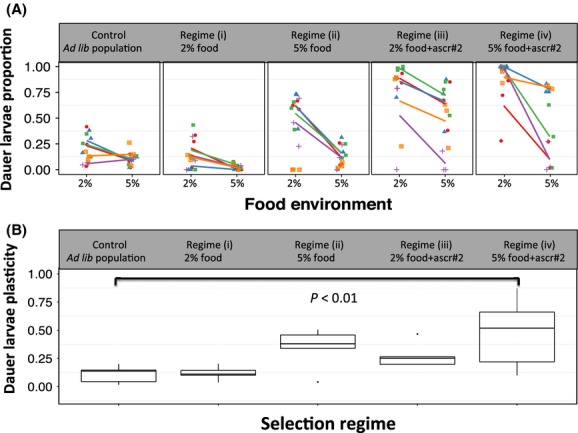
(A) The proportion of dauer larvae formed by lines selected in regimes (i)–(iv), and of the control, unselected population, tested in two food (2% and 5% w/v) environments. Each line and colour represents the mean dauer formation of each inbred line, with the data for each repeat shown by symbols, where each symbol shape is one inbred line. (B) Variation in the plasticity for dauer larva formation calculated as the absolute difference in dauer larvae formation between the 2% and 5% food environments. The boxplot shows the median (horizontal line), upper and lower quartiles (box), the data range (whiskers), and outliers (circles). P-values show changes in the plasticity of dauer larva formation compared to the control population (Appendix Table4).